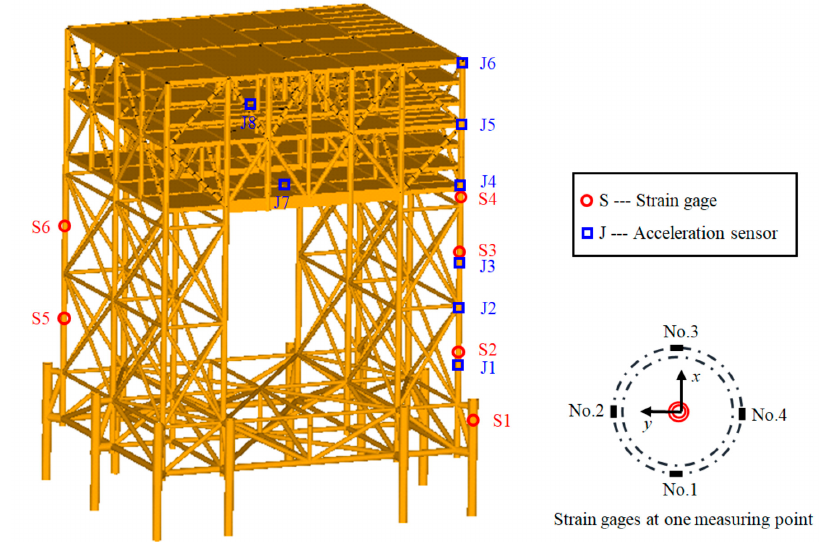
Figure 5. Measurement positions of dynamic response at key nodes of the electrical platform.